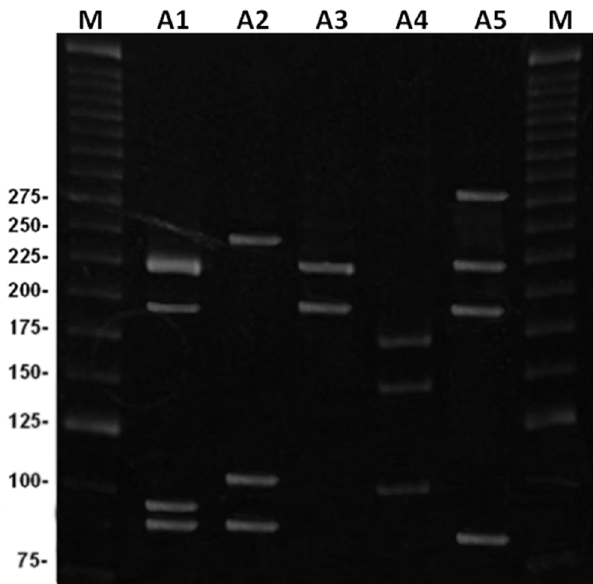
Figure 2 Electrophoretic analysis of the HPV genotyping in semen using PCR-RFLP with restriction enzyme Hpy CH4V in 8% polyacrylamide gel stained with ethidium bromide. Sample A1, genotypes 2 16 (High-risk, HR) and 2 31 (HR) in double HPV infection (216, 191, 94 and 91 base pairs-bp); A2, genotype 2 13 (low-risk, LR) in single HPV infection (244, 103 and 91 bp); A3, genotype 2 16 (HR) in single HPV infection (216 and 191 bp); A4, genotype 2 18 (HR) in single HPV infection (174, 144 and 100); A5, genotypes 2 81(LR), 2 66 (HR) and 2 16 (HR) in multiple HPV infection (284, 216, 191 and 89 bp). M, molecular weight marker (25 bp).